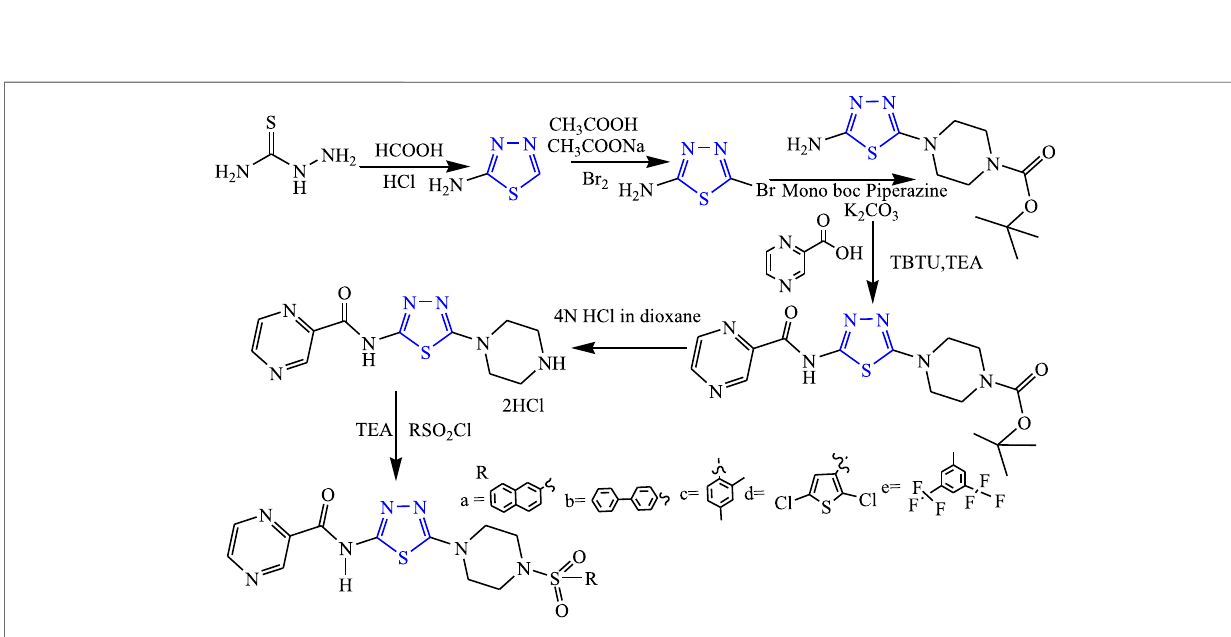
Frontiers in Chemistry |